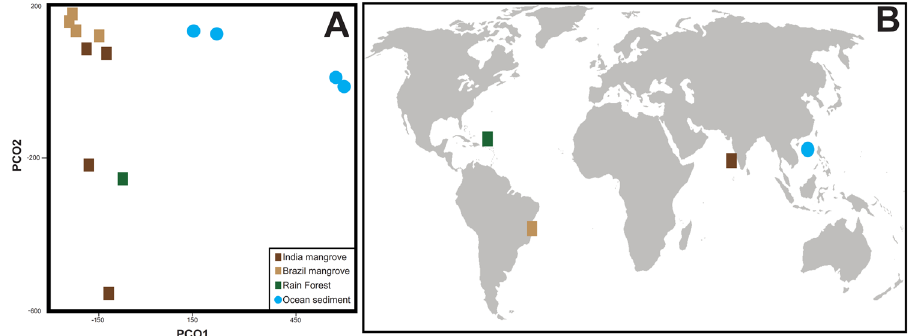
Figure 5. Principal Component Analysis and geographic location of samples compared across the globe. A. PCA analysis comparing mangrove forests, a rain forest, and four ocean sediment samples. B. Geographic locations of the samples that were compared in this analysis. (Image source- Link:https://commons.wikimedia. org/wiki/File:BlankMap-World-noborders.pngand Inkscape v0.92 was used for